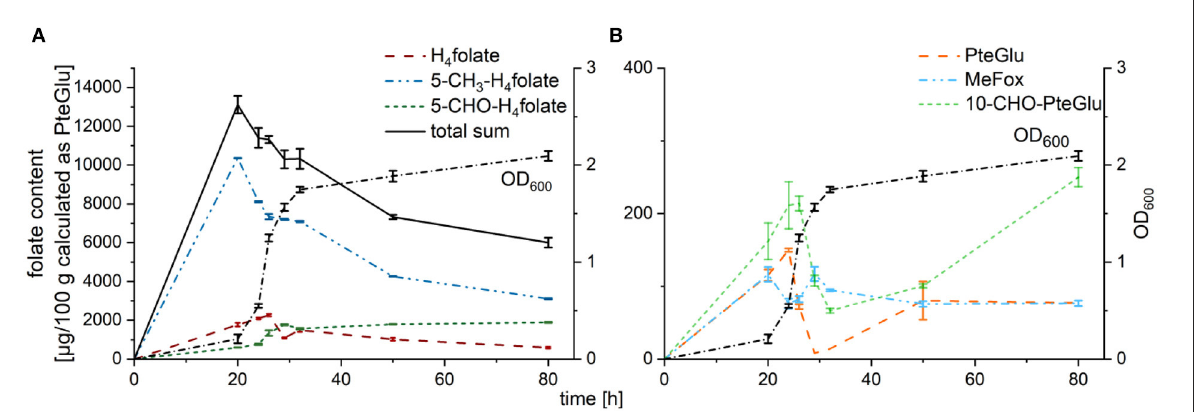
FIGURE2 Folate contents of different vitamers in TUM68 ® yeast during cultivation after enzymatic deconjugation, calculated as µ g/100g PteGlu (dry weight, d.w.); with (A) main vitamers H 4 folate (red), 5-CH 3 -H 4 folate (blue), 5-CHO-H 4 folate (darkgreen), and the total sum (black) in comparison to the optical density (OD 600 , dotted line), (B) oxidation products PteGlu (orange), MeFox (lightblue), and 10-CHO-PteGlu (leafgreen) in comparison to the optical density (OD 600 , dotted line). Data are expressed as mean values ± confidence